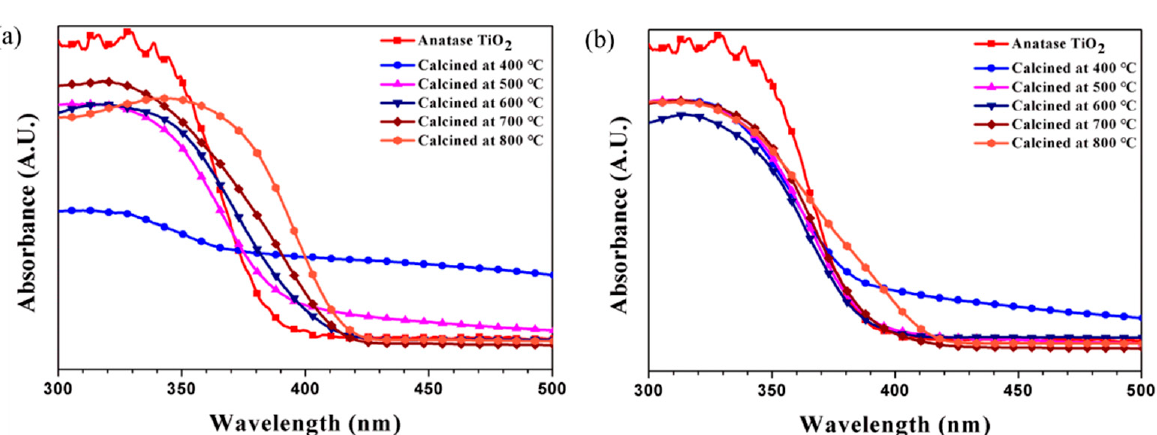
Figure 9. Absorption spectrum of titania hollow spheres with different calcination temperatures under UV light: ( a ) CS1 and ( b ) CS3.